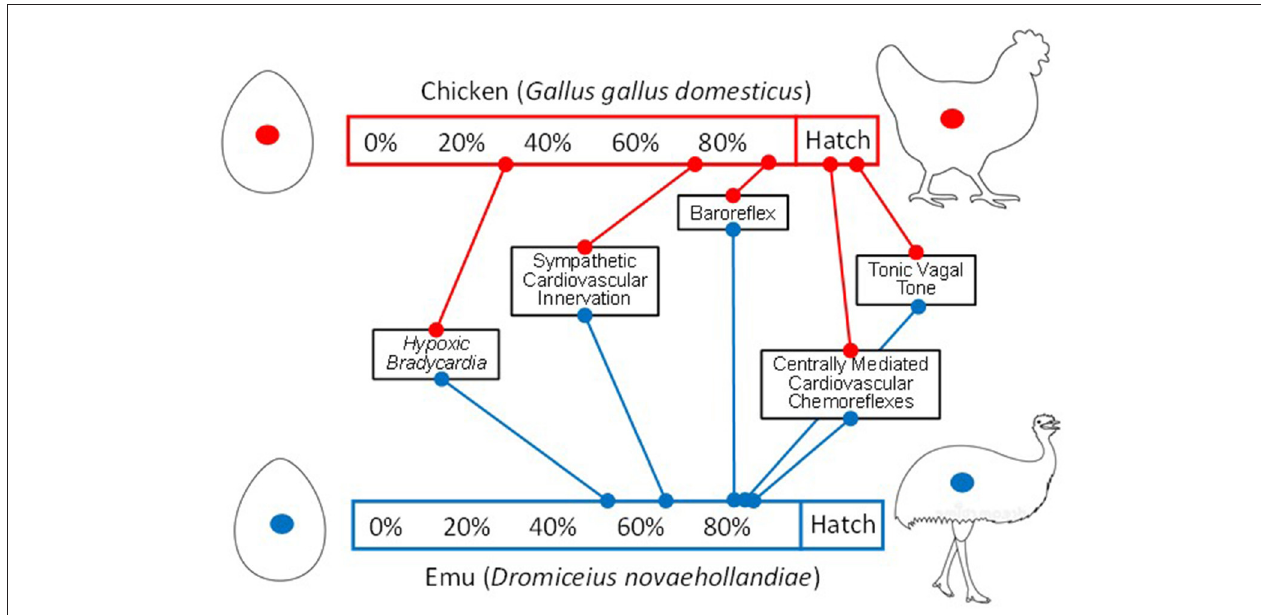
FIGURE 3 | A comparison of the onset of elements of cardiovascular control in the developing embryo of the domestic chicken and the emu. Development has been normalized to 100% of development, followed by a hatching period. Note that major developmental landmarks in the emu occur later (e.g., hypoxic bradycardia) or earlier (e.g., onset of tonic vagal tone) than in the domestic chicken. This raises the question “Which species is ‘representative’?" (modified from Crossley et al., 2003; Dzialowski and Greyner, 2008).